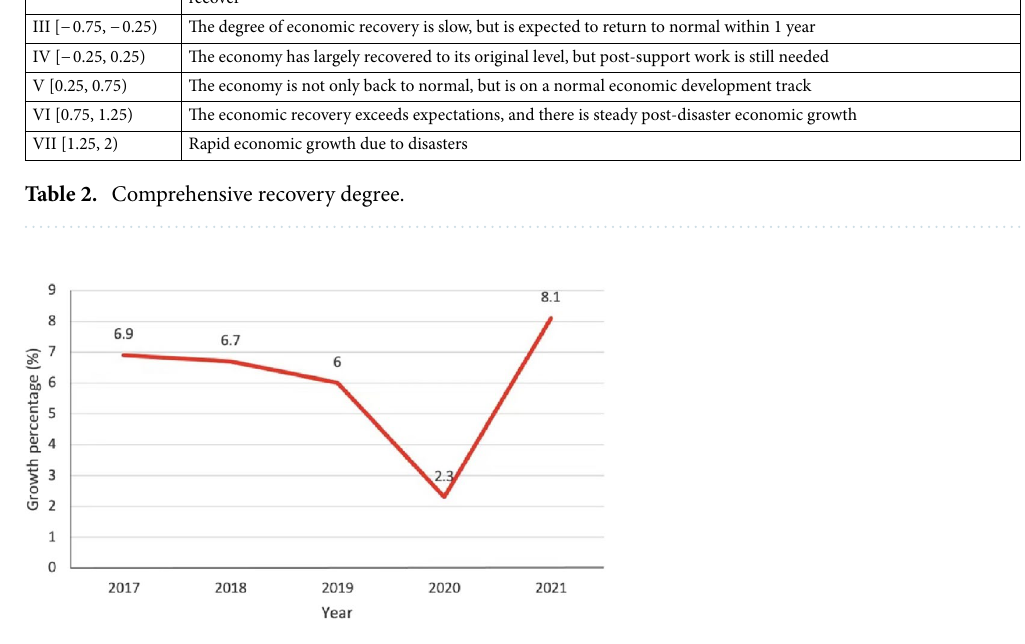
Figure 1. China’s GDP Growth Rate (2017–2021). Source: WIEGO statistical